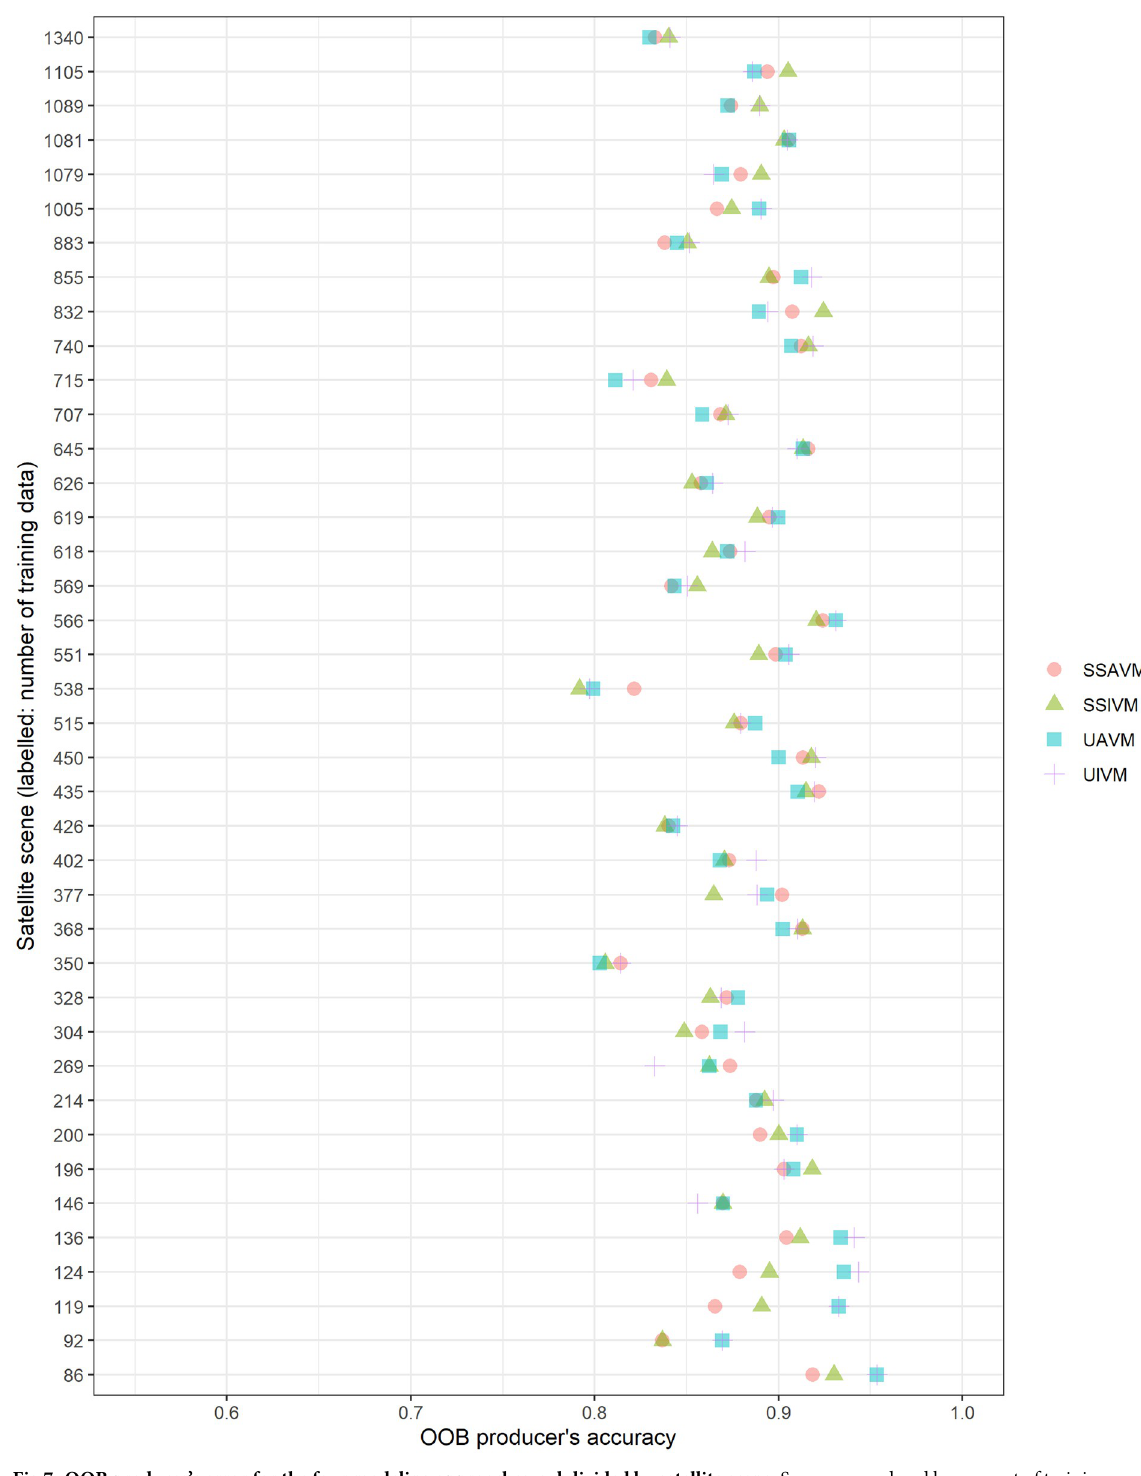
Fig 7. OOB producer’s error for the four modeling approaches, subdivided by satellite scene. Scenes are ordered by amount of training data.